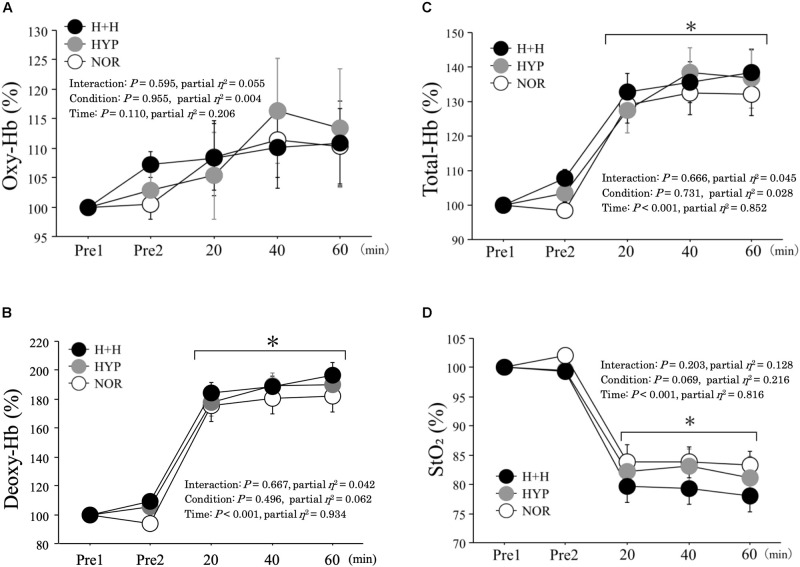
Oxy-hemoglobin (A), deoxy-hemoglobin (B), total-hemoglobin (C), tissue oxygen saturation (D) during exercise. All values were expressed as relative value (values were expressed in refer to pre-exercise value). Pre1 indicates rest under normoxic condition (normal temperature). Pre2 indicates rest under each condition. Values are means ± SE. ∗P < 0.05 vs. Pre1.